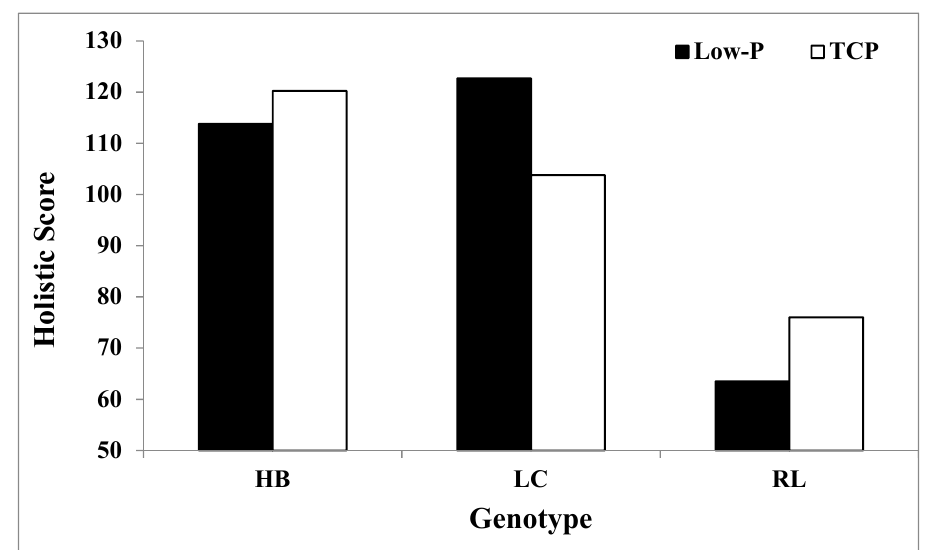
Figure 5. Holistic scores for the low-P tolerance of the potato varieties based on the measurements of P uptake, P utilization efficiency, and biomass produced by the individual varieties grown in hydroponics for 28 days. Low P: 1 mg L − 1 P as water soluble P, NaH 2 PO 4 ; and 286 mg L − 1 TCP, tri-calcium phosphate, Ca 3 (PO 4 ) 2 as sparsely soluble P with 2286 mg L − 1 laboratory grade Ca 3 (PO 4 ) 2 . HB: ‘Harley Blackwell’; LC: ‘La Chipper’; RL: ‘Red LaSoda’. The bars are the values of LSD 0.05, 2 for the plant biomass of the control, low P and TCP, respectively.